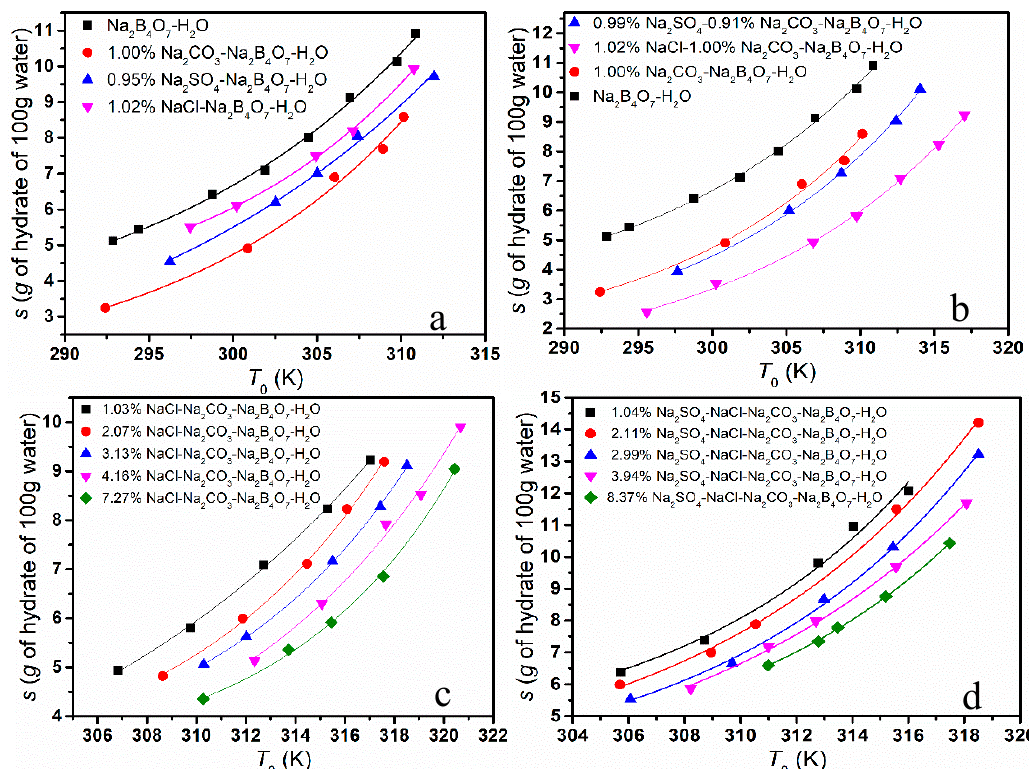
Figure 3. The solubility of borax in di ff erent systems. ( a ) single salt system; ( b )double salt system; ( c ) NaCl-Na 2 CO 3 -Na 2 B 4 O 7 -H 2 O systems; ( d ) Na 2 SO 4 -NaCl-Na 2 CO 3 -Na 2 B 4 O 7 -H 2 O system;